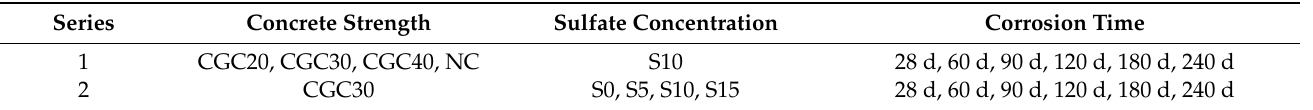
Table 3. Detailed test design of factor level.